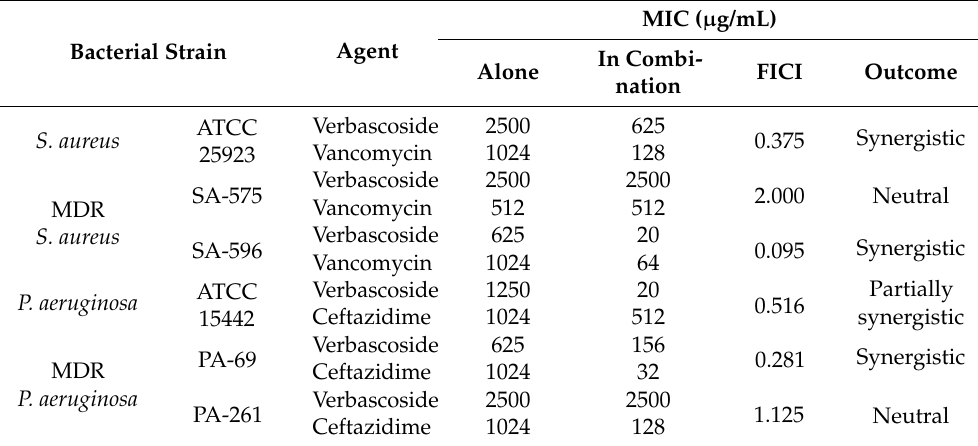
Table 2. Results of the application of verbascoside combined with antibiotics against Staphylococcus aureus and Pseudomonas aeruginosa .